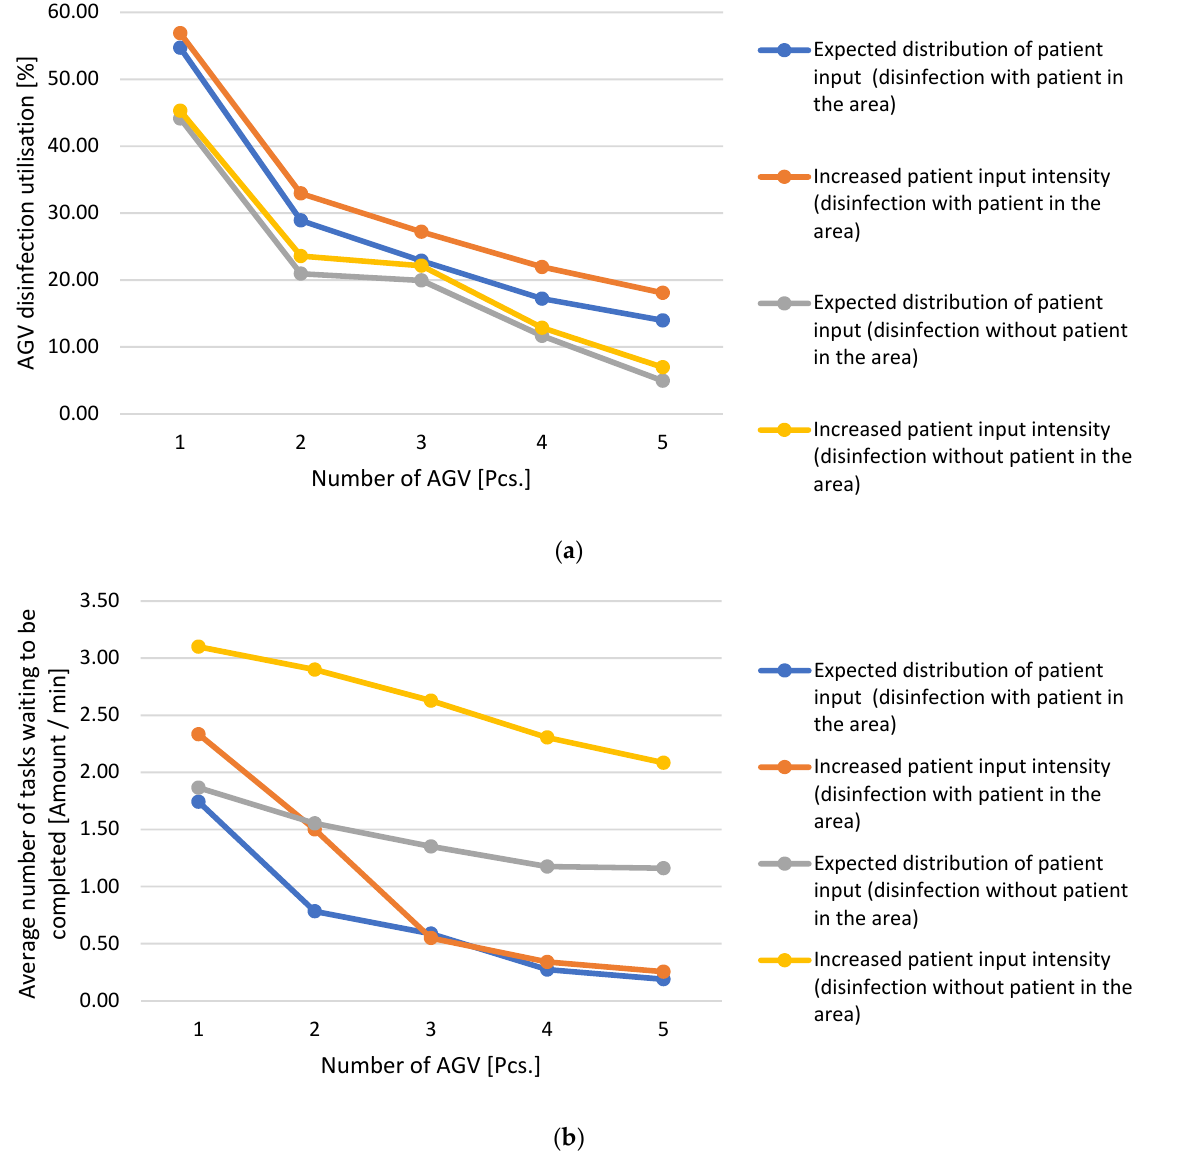
Figure 14. Results of simulation experiments processed graphically: ( a ) for AGV disinfection utilisation; ( b ) for an average number of tasks waiting to be completed.